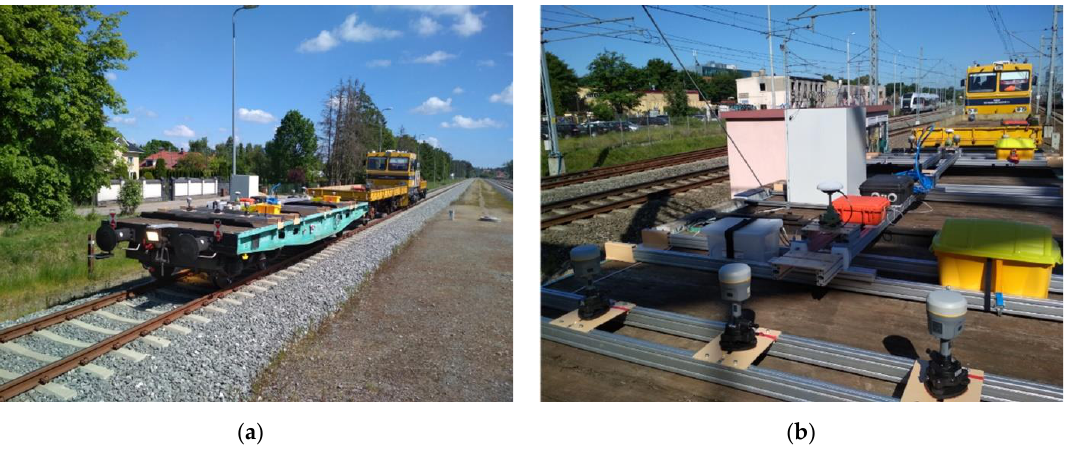
Figure 6. MMP ( a ) with the equipment used ( b ) during the railway measurement campaign conducted on 9 June 2021.